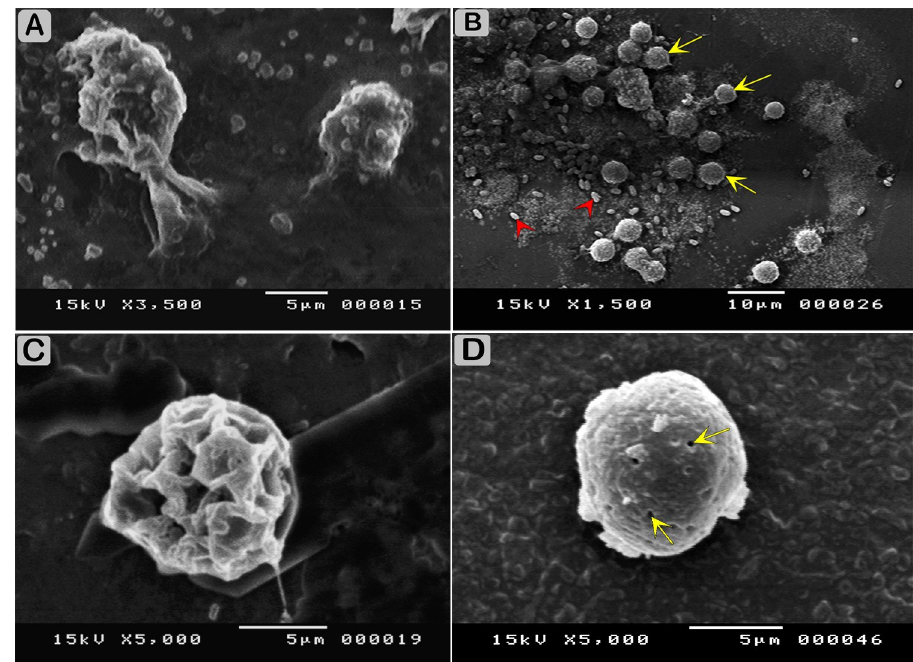
Fig 4. Scanning electron micrographs of A . polyphaga showing morphological stages. (A) Trophozoite of A . polyphaga showing irregular cell shape and acanthopodia structure. (B) SEM showing numerous cysts (yellow arrows) and bacteria cells (red arrow heads). (C) SEM of A . polyphaga cyst showing the typically wrinkle appearance with high ridges over the surface. (D) SEM of Acanthamoeba cyst showing ostioles (yellow arrows) that connect the endocyst and ectocyst layers.